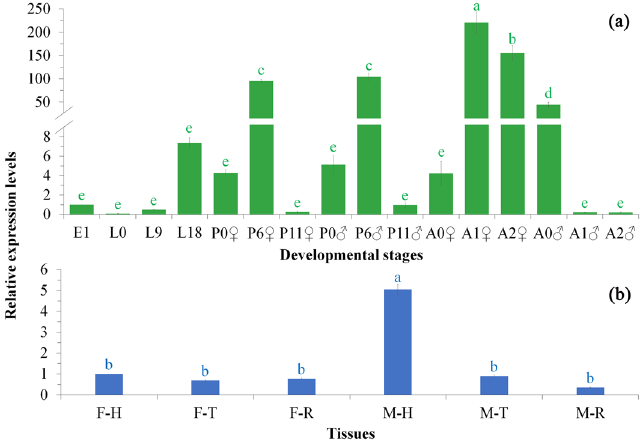
Figure 3. The expression of Sl - NTL in relation to development, sex and tissues. ( a ) expression patterns in the eggs and whole body of insects from different developmental stages. E1 refer to 1-d-old eggs; L0, L9 and L18 refer to 0-(1st instar), 9-(3rd instar) and 18-d-old (6th instar) larvae; P0 ♀ , P6 ♀ and P11 ♀ refer to 0-, 6- and 11-d-old female pupae; P0 ♂ , P6 ♂ and P11 ♂ refer to 0-, 6- and 11-d-old male pupae; A0 ♀ , A1 ♀ and A2 ♀ refer to 0-, 1- and 2-d-old adult virgin females; and A0 ♂ , A1 ♂ and A2 ♂ refer to 0-, 1- and 2-d-old adult virgin males. Expression in 1-d-old eggs was set as calibrator. ( b ) expression levels in 0-d-old male and female heads, thoraxes and reproductive systems. F–H, F–T and F–R refer to female heads, thoraxes and reproductive systems; M–H, M–T and M–R refer to male heads, thoraxes and reproductive systems; Expression in female heads was set as calibrator. For each parameter (Developmental stages or Tissues), bars with different letters are significantly different ( P < 0.05); i.e., letters with the same color can be compared to derive the significance of difference between